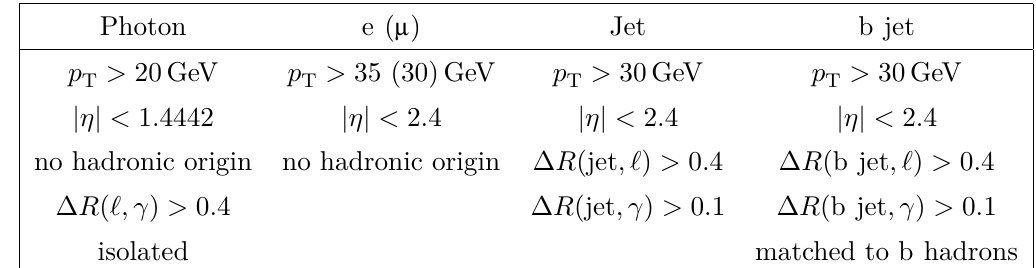
Table 2 . Overview of the definition of fiducial regions for various objects at particle level. A photon is isolated, if there are no stable particles (except neutrinos) with p of ∆ R = 0 . 1